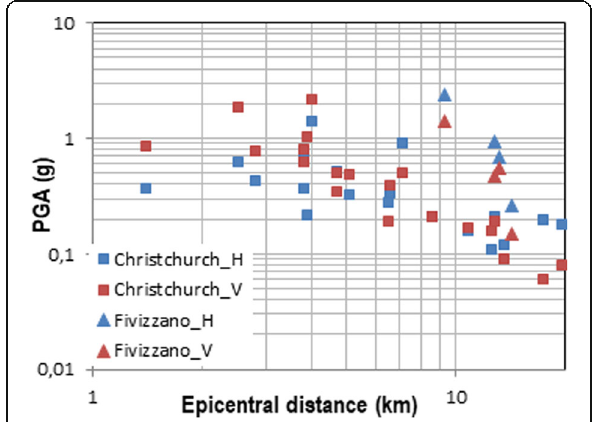
Fig. 5 Horizontal and vertical PGA values recorded within the first 20 km epicenter distance during 1) 22 February 2011 Christchurch earthquake (6.3 M w ) (square) and 2) 21 June 2013 Fivizzano earthquake (5.1 M w )